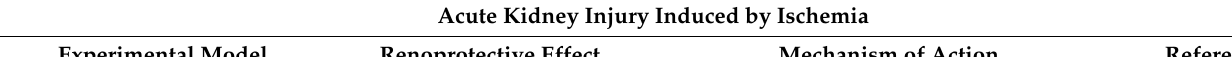
Table 1. Renoprotective effects of luteolin in animal models of acute kidney injury